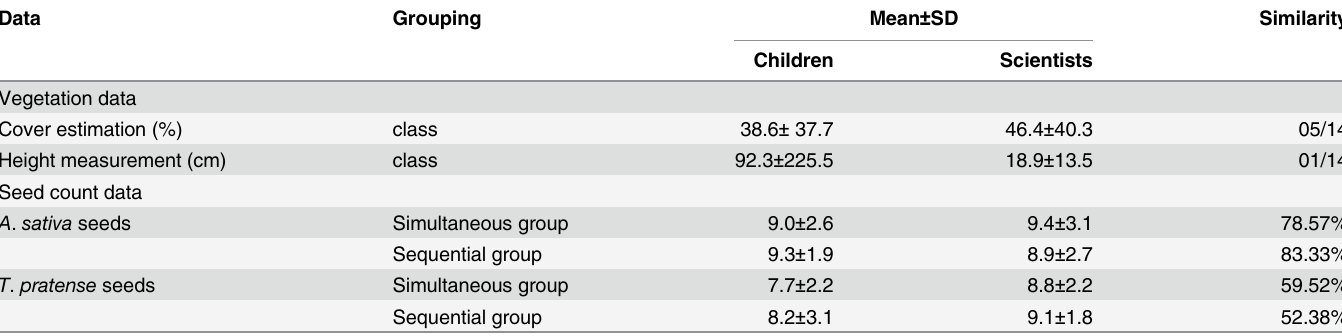
Table 1. Comparison of vegetation cover, height and seed count data collected by children and scientists.